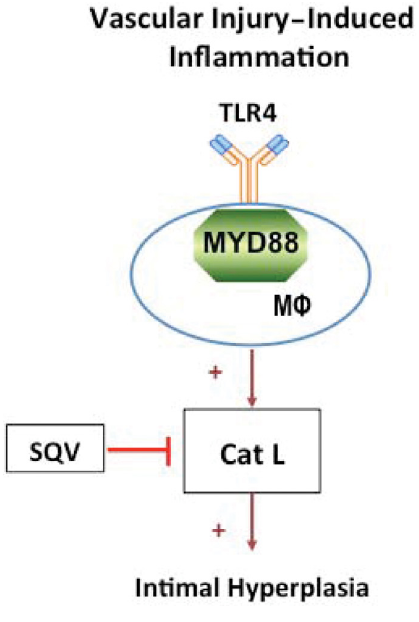
Figure 4. An illustration of potential mech-